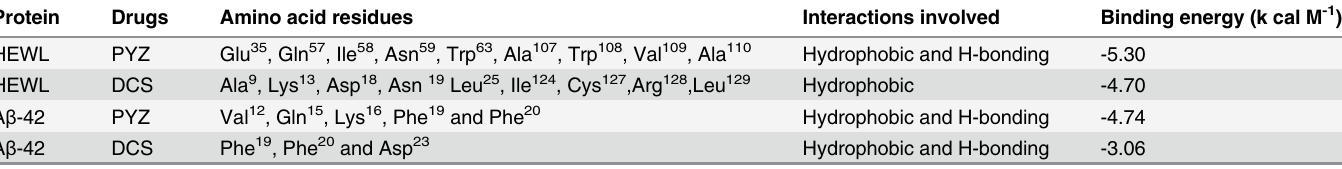
Table 4. Molecular docking parameters of drugs (PYZ/DCS)-protein